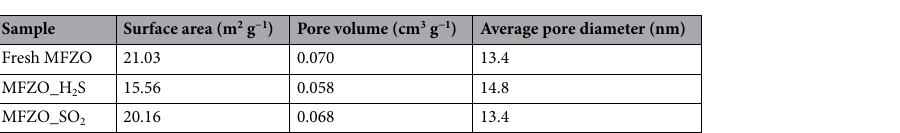
Table 1. Surface area and pore characteristics of wet MFZO before and after gas adsorption.